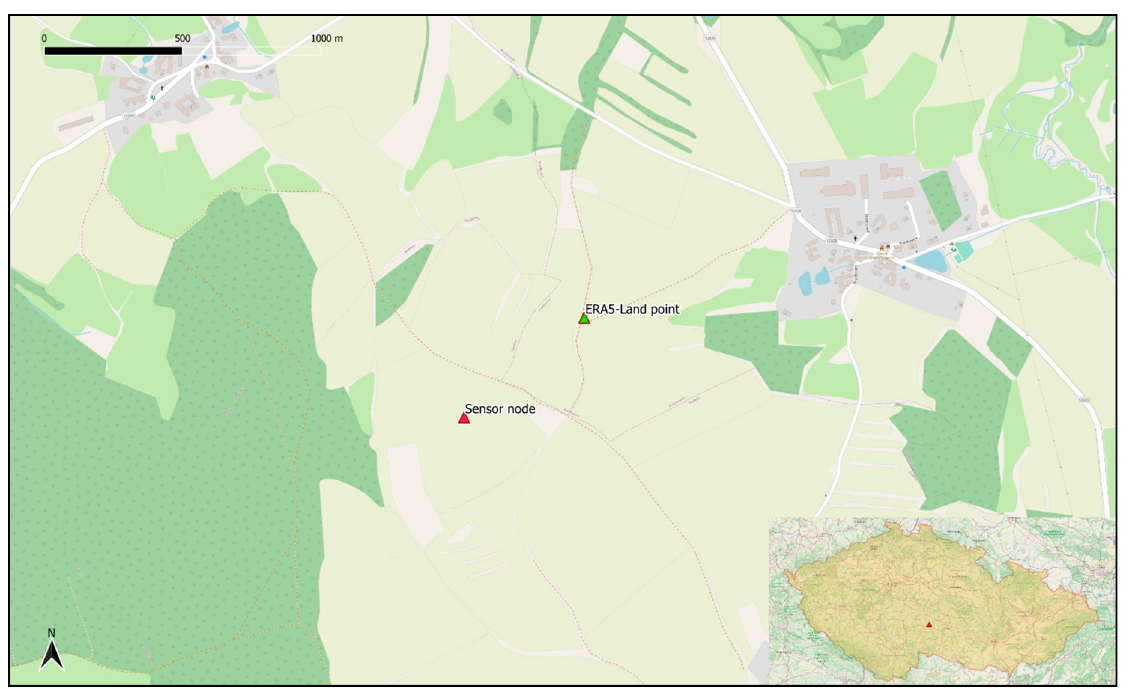
Figure 1. Location of the sensor node, and reference point for ERA5-Land model, location of the locality in the Czech Republic (overview map).